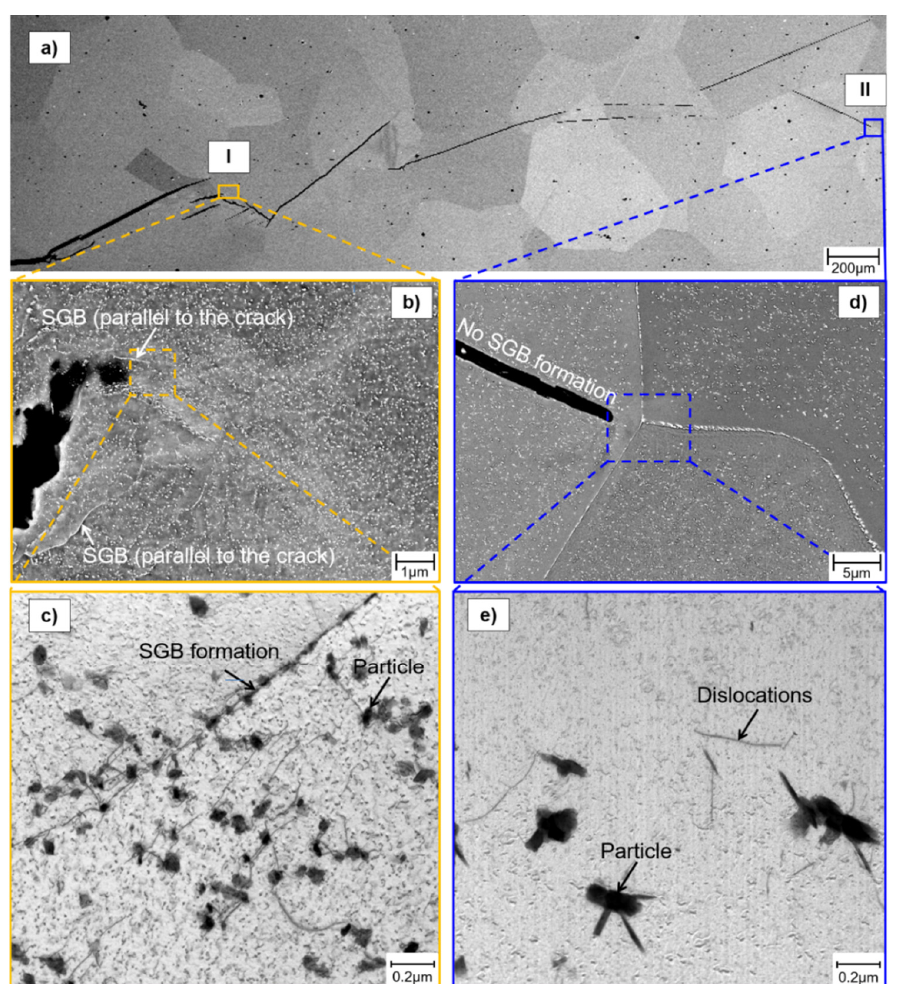
Figure 12. SEM investigations show ( a ) crack path in precipitation-annealed (PA) Crofer ® 22H (650 °C, 20 Hz), terminated in the initial range of Δ K ↑ with da/dN ↓ ; ( b , c ) position I: crack front with sub-grain formation and a multitude of small precipitates; ( d , e ) position II: no sub-grain formation, few large precipitates.